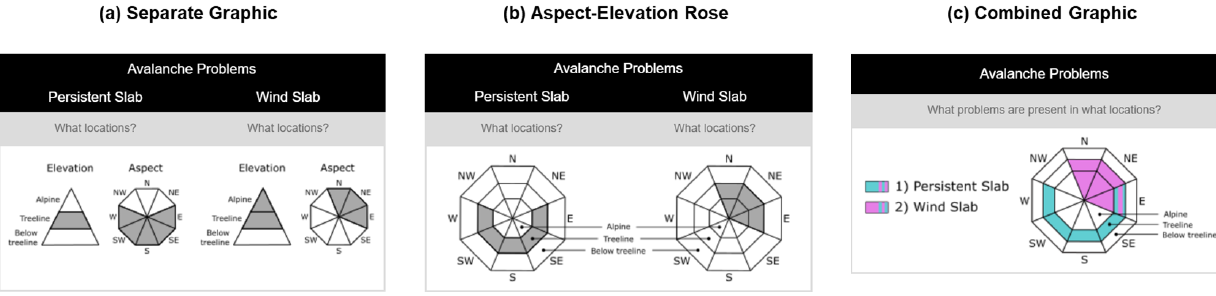
Figure 3. Presentation formats for location information of avalanche problems. Separate graphics (a) , aspect–elevation rose diagram (b) , and combined graphic (c)